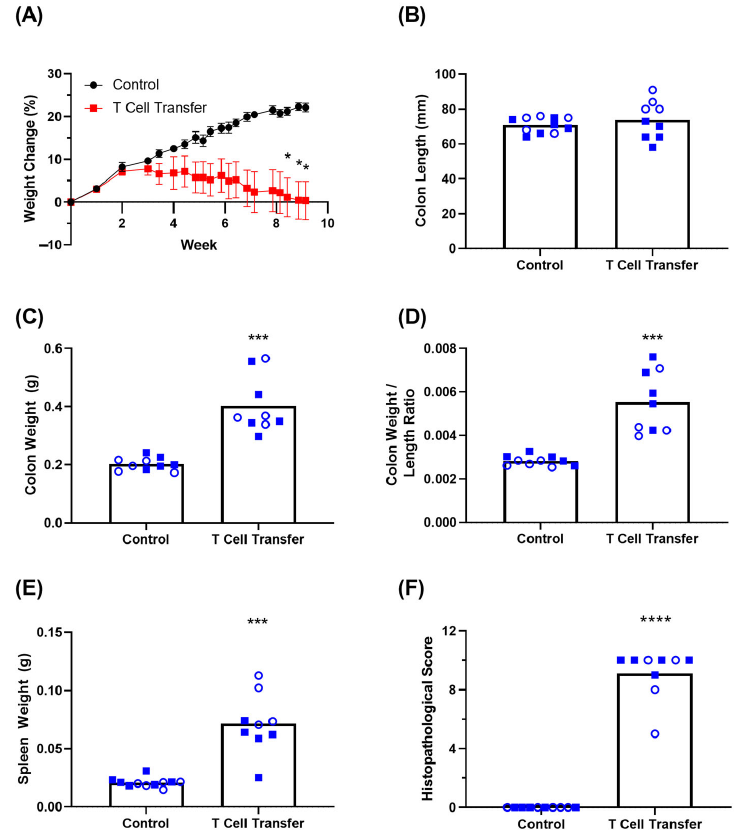
Figure 3. Clinical signs of disease within the chronic, adoptive T cell transfer experimental colitis model. Rag KO mice (n = 10/group) were injected i.p. with proinflammatory (CD4+ CD25 LOW CD45RB HIGH isolated from spleens of C57BL/6 mice. Body Weight Change (%) over the course of the study is shown (Panel ( A )). For animals euthanized during the course of the study, the last recorded weight loss was used for time points post ‐ euthanasia. Colons were collected once animal were euthanized at the end of the study period or for reaching a humane endpoint, and examined for their length (Panel ( B )), weight (Panel ( C )) and related to one another for a Weight/Length Ratio (Panel ( D )). Isolated spleens were also weighed (Panel ( E )). Colons were then fixed, H&E ‐ stained and analyzed for a Histopathological Score (Panel ( F )). Data are presented as mean + standard error of mean (SEM). Circles and squares represent Rag1 ‐ / ‐ and Rag2 ‐ / ‐ mice, respectively. Statistical significance of differences is compared relative to the control group and is shown as *: p < 0.05, ***: p < 0.001, ****: p < 0.0001 by two ‐ tailed unpaired parametric t ‐ tests with the Welch’s cor ‐